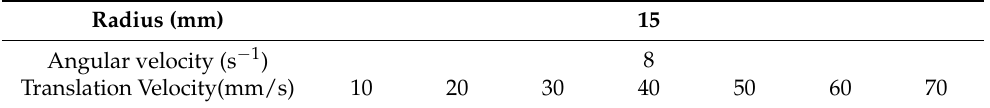
Figure 9. Variation curve of powder layer density under different translation velocities of powder recoaters. Table 4. Motion parameters and structural parameters with different translation velocities during the movement of the powder